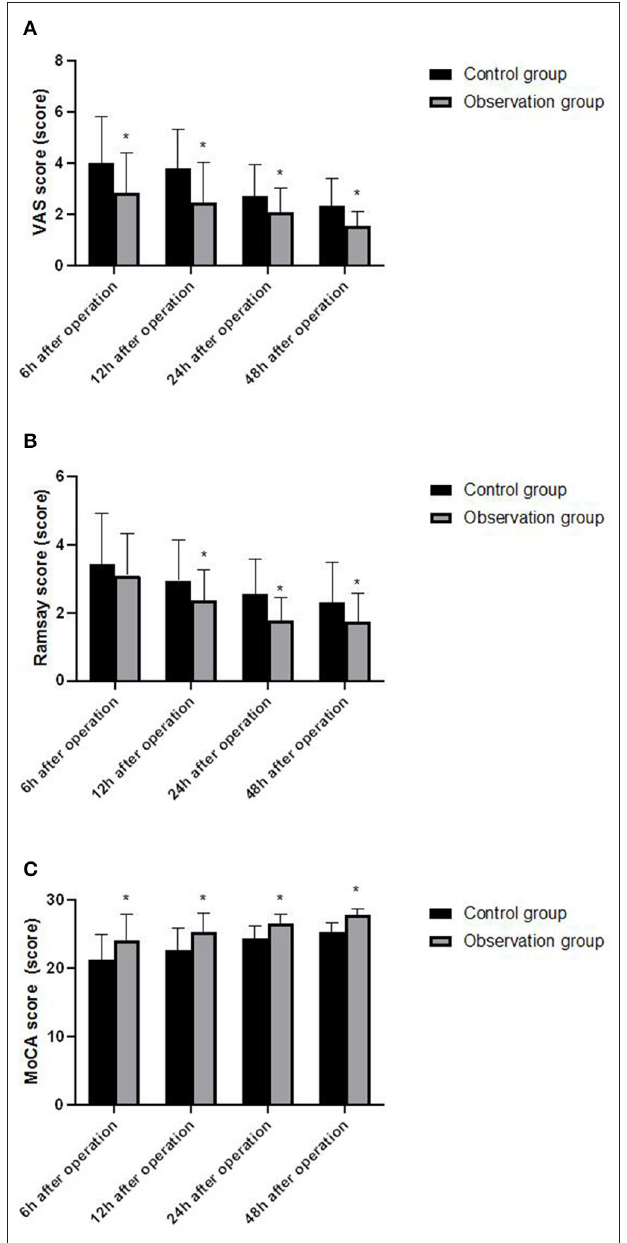
FIGURE 2 | Comparison of VAS score, Ramsay score and MoCA score between the two groups of patients at different time points. (A) VAS score; (B) Ramsay score and (C) MoCA score. Compared with the control group, * P <